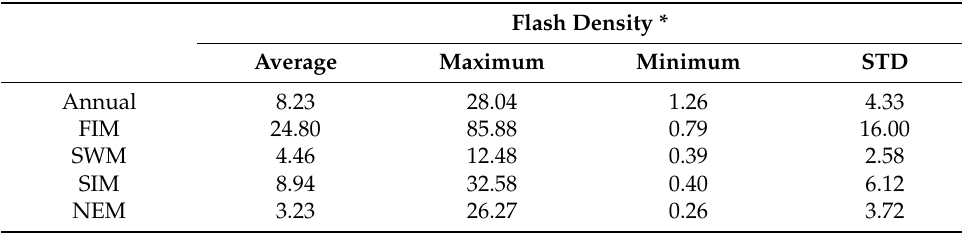
Table 4. Statistical overview of the seasonal variation of lightning flash density (flashes/(km 2 · year)) over the considered buffer zone of the railway network from 1998 to